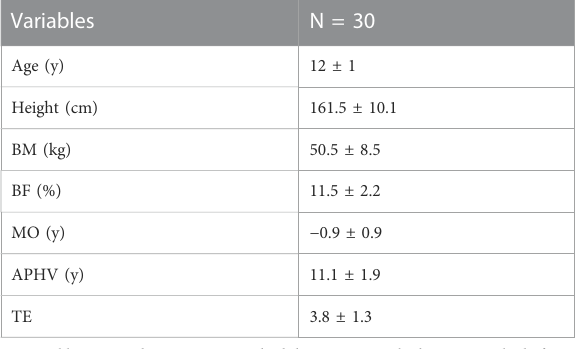
TABLE1Participant ’ santhropometricanddynamicstrengthcharacteristics in the whole sample of male young volleyball players.